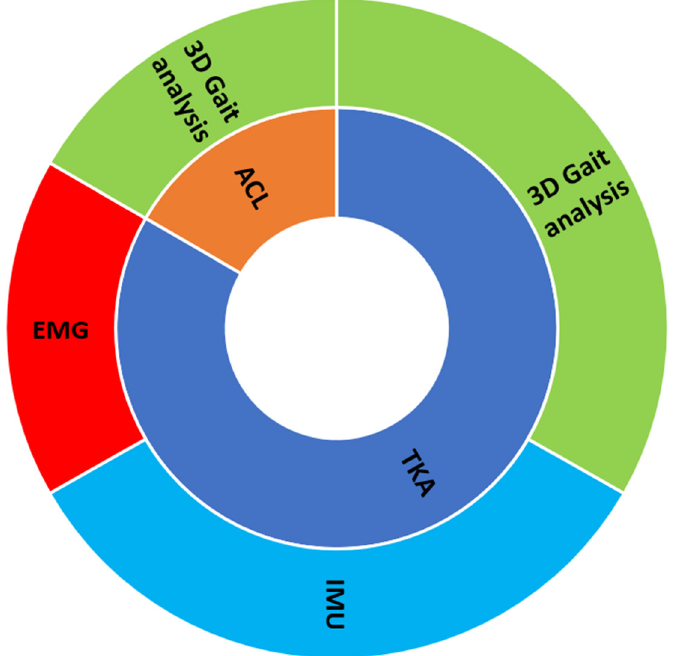
Figure 3. Type of data of the employed